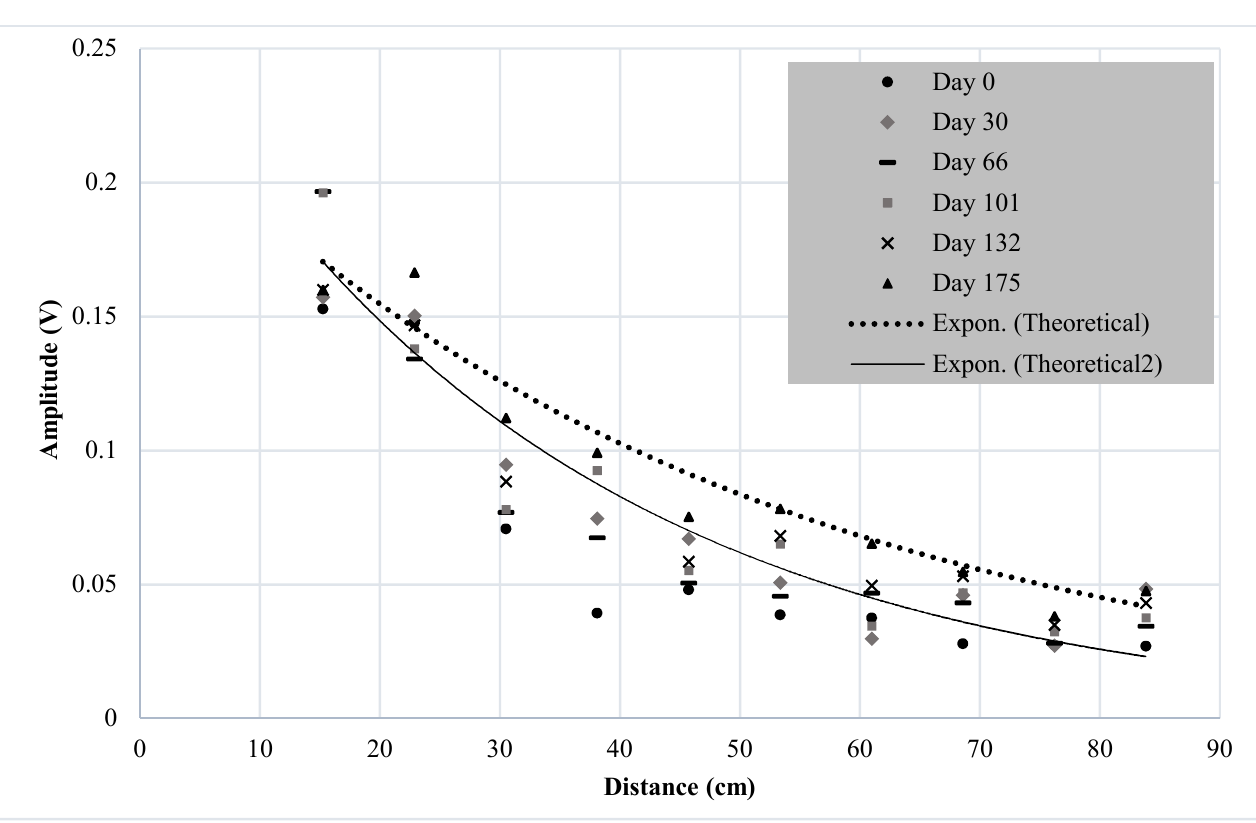
Figure 7. Specimen A: UGWL amplitude change for two sensor points over 175 days. As can be seen in Figure 7, there is some fluctuation in the UGWL amplitude meas- urements. This fluctuation is attributed to testing or user errors (such as the sensor loca- tion being slightly different from the previous test, different amounts of couplant used, etc.) as well as the effects of ambient noise. However, when the change in the condition is significant enough (i.e., when a significant amount of corrosion product is built up), there is a significant (or “permanent”) change in the amplitude values. Table 3 quantifies the change in amplitudes for these two points over the entire period of the experiment. On the 175th day, the percent change in the amplitude for the 38 cm (15 in) point is approximately 154%, while for the 53 cm (21 in) point it is 105%. When the general trend is studied, regardless of the day-to-day fluctuations, a permanent change in amplitude occurs after roughly a 50% change is established. This happens at day 18 for Point 1 (38